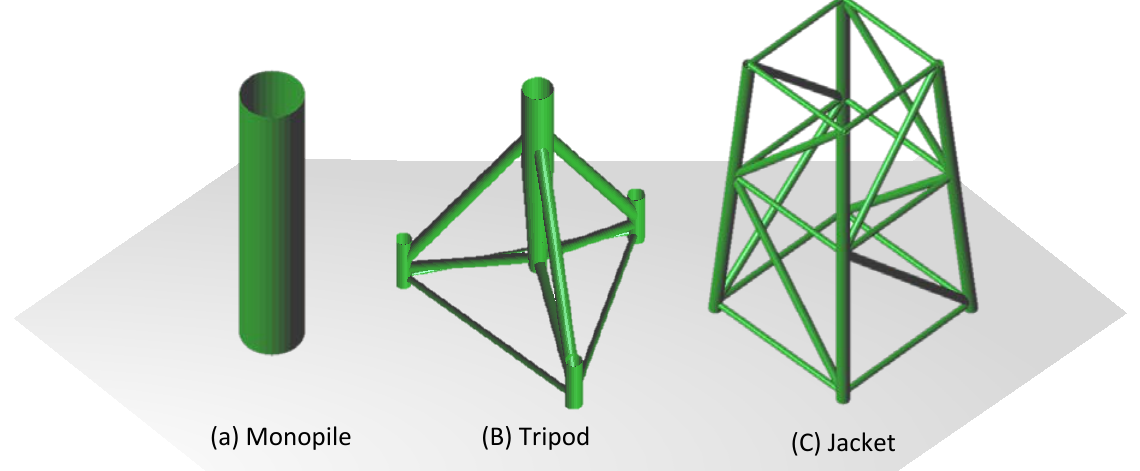
Figure 1. Three common types of offshore wind turbine foundations.